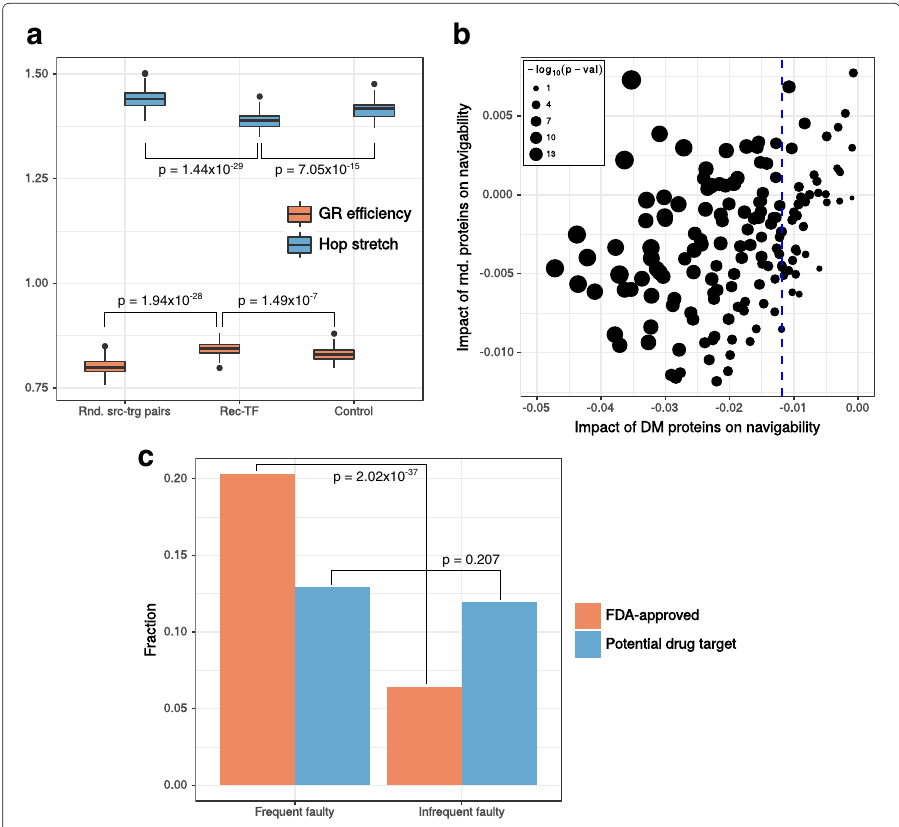
Fig. 4 Disease proteins affect signal transduction. a Reference greedy routing (GR) efficiency and hop stretch of the hPIN (Rnd. src-trg pairs) compared to the efficiency (hop stretch) achieved if signals are routed between receptors (Rec) and transcription factors (TF) or between proteins that are neither Recs nor TFs, but that have degrees similar to their counterparts (Control). b Impact on GR efficiency (navigability) dealt by faulty proteins sampled from the set of proteins associated with a DM or from a pool of proteins with similar degrees. The blue dashed line indicates the value of the highest impact (i.e. the most negative) from the latter case. c Frequently used faulty proteins are more likely to be FDA-approved drug targets or potential drug targets than infrequent faulty proteins. P -values are the result of a Fisher’s test comparing the proportion of FDA-approved or potential drug targets in frequent vs infrequent faulty